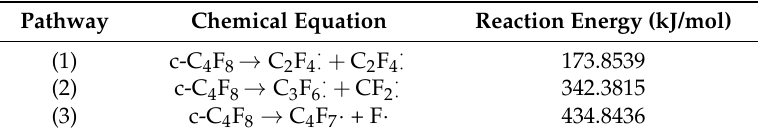
Table 3. c-C 4 F 8 discharge decomposition path.